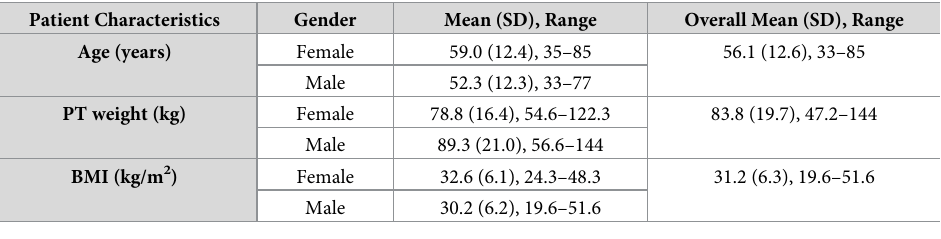
Table 1. Summarised patient